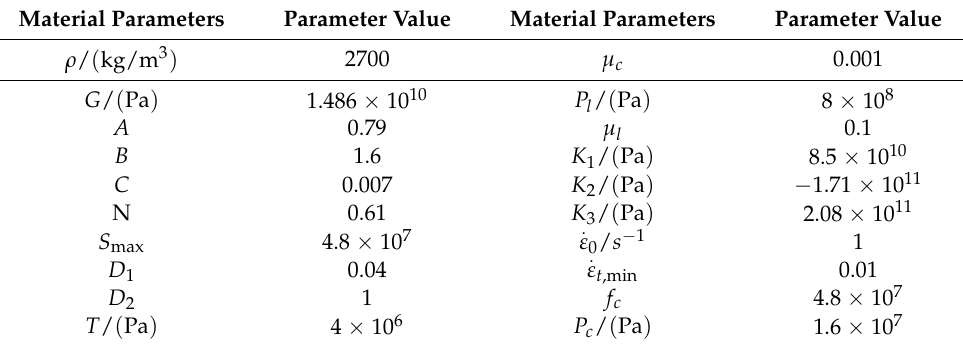
Table 3. Material parameters of surrounding